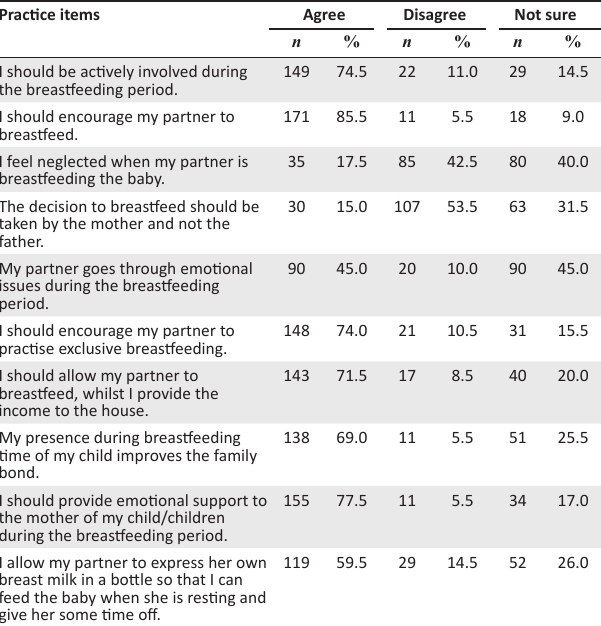
TABLE 2 (Continues...): Responses to exclusive breastfeeding knowledge items. TABLE 4: Practices related to exclusive